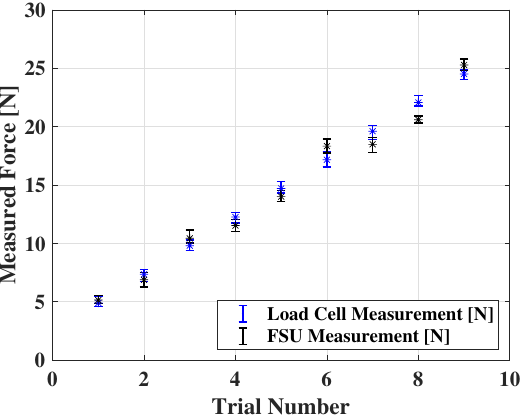
Figure 9. The comparison between a commercial load cell and our FSU under various force loads.